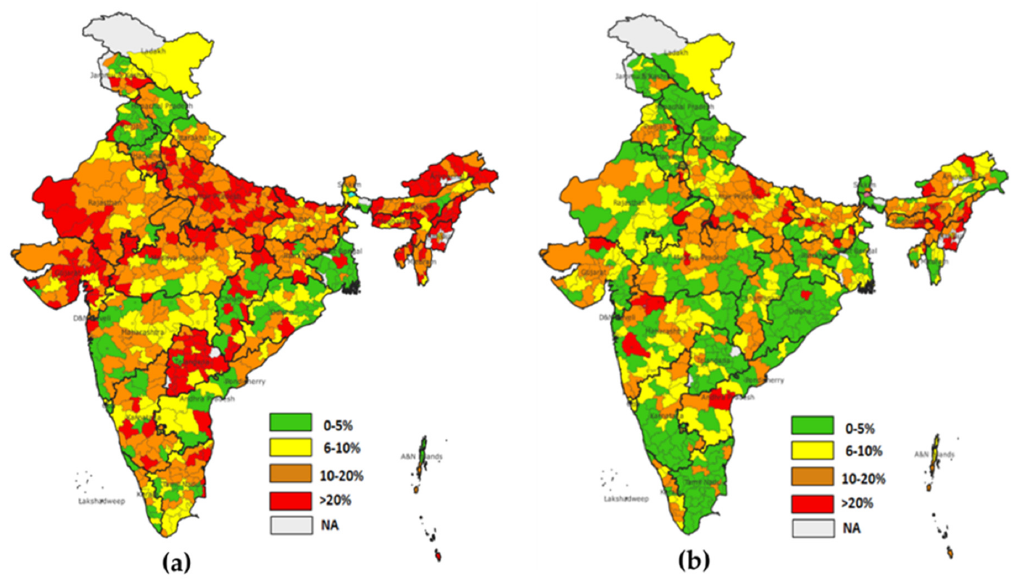
Figure 7. ( a ) District level dropout rate for BCG-MCV1 (NFHS-4), ( b ) district level dropout rate for